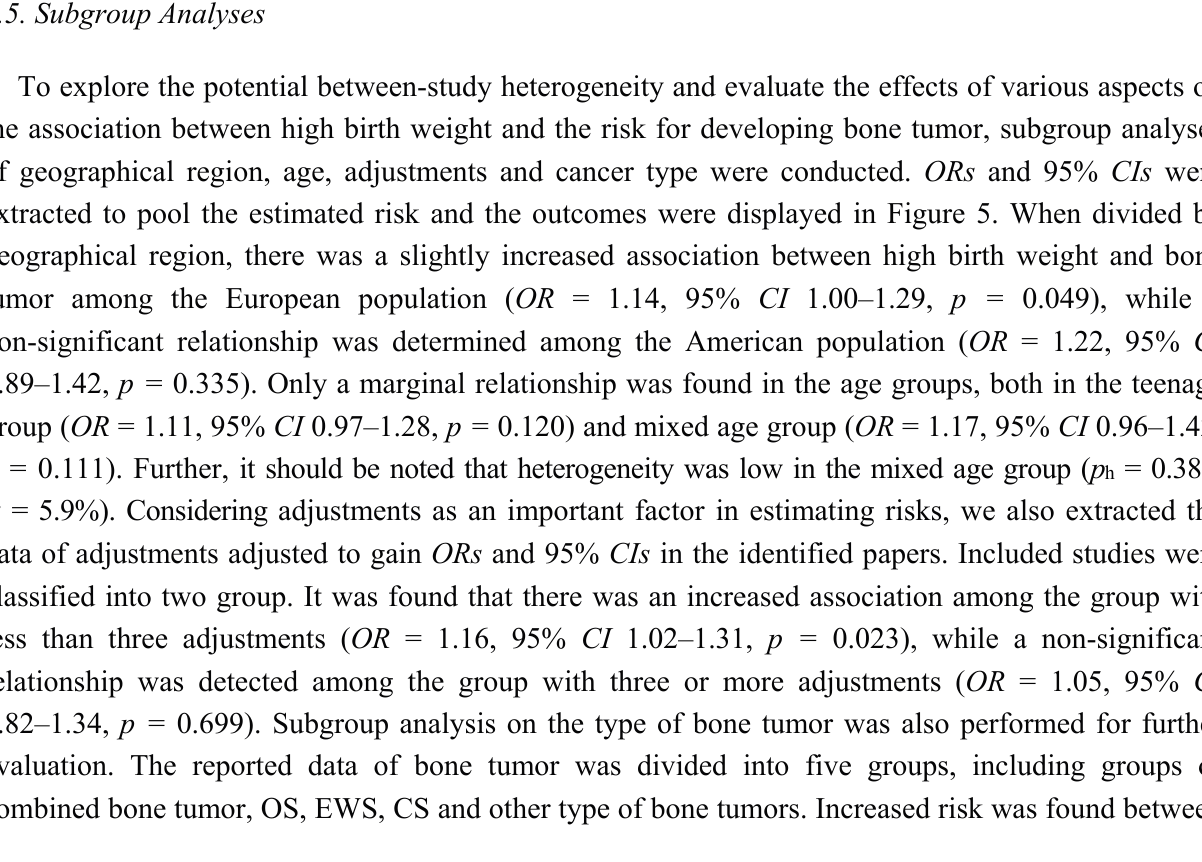
Figure 4. Results of leave-one-out method in sensitivity analysis. The three vertical dotted lines denote the pooled fixed effect of OR and 95% CI ( OR = 1.13, 95% CI 1.01–1.27), while the solid vertical line shows the OR of 1. The horizontal lines and the circles indicate the ORs and 95% CIs applying the leave-one-out